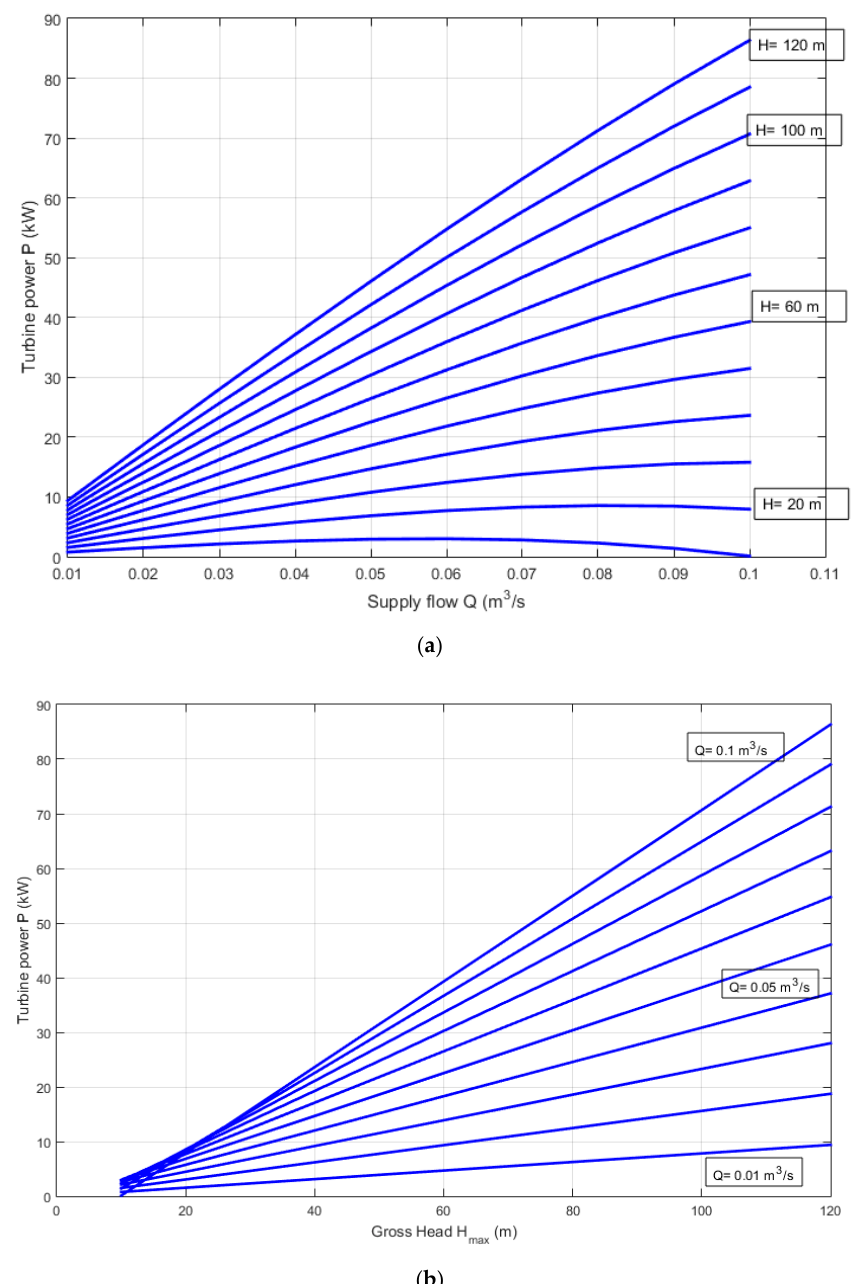
Figure 1. In the same way, the typical hydropower turbine could be used is Pelton or Turgo turbine with the highest flow, 0.1 m 3 /s and high gross head range. Cross-flow turbines are also considered best for pico-hydro projects with a head of 10 m or less and water flow nearly to 0.1 m 3 /s.